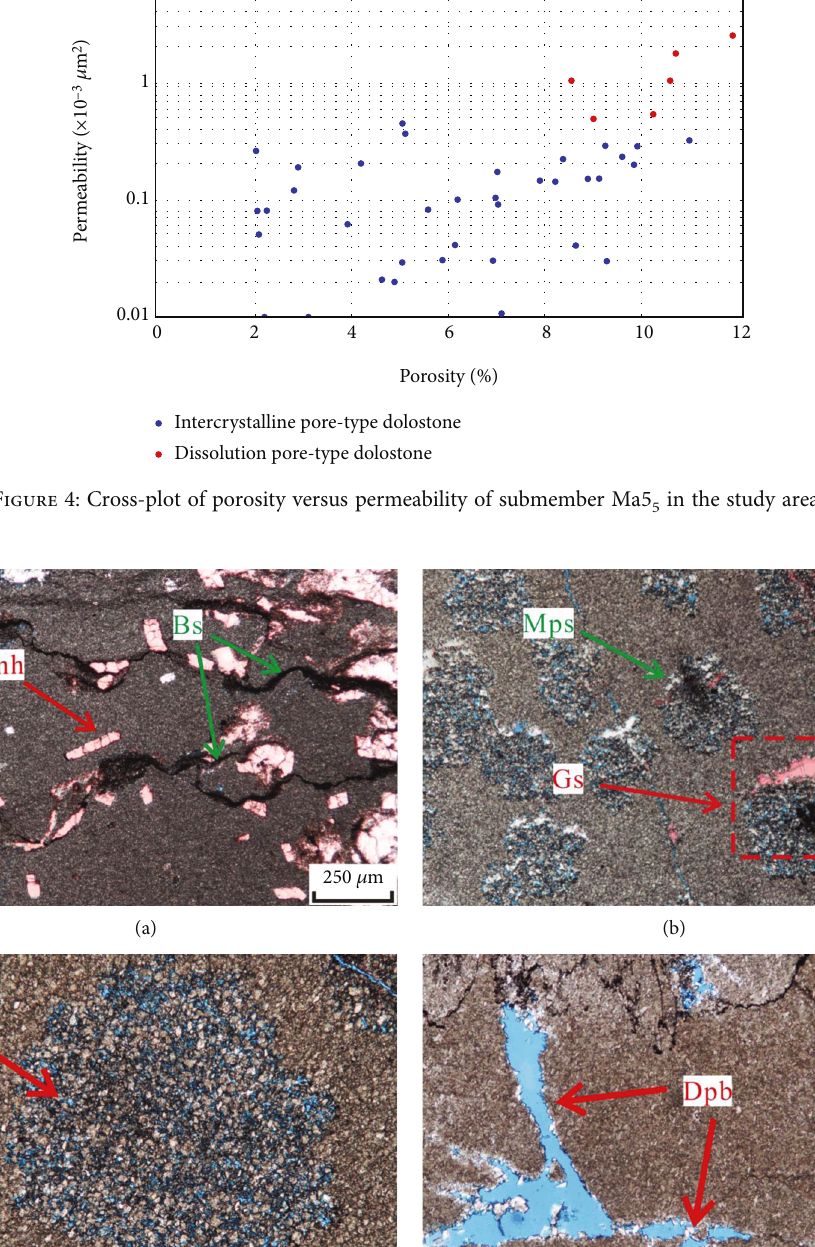
Figure 5: Lithofacies characteristics of dissolution pore-type dolostone reservoir. (Anh = anhydrite; Bs = breccia structure; Mps = moldic pore by salt dissolution; Gs = geopetal structure; Dpb = dissolved pore between breccias). ((a) Dissolved collapse breccia structure, 3859.85m, well Y1112; (b) moldic pore by salt dissolution, and geopetal structure, 4089.80m, well Y1165; (c) moldic pore, 4089.80m, well Y1165; (d) dissolved pore between breccias, 3952.10m, well